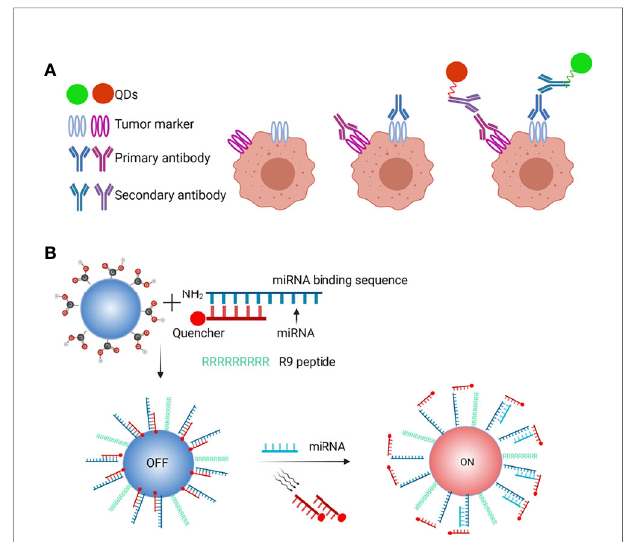
FIGURE 5 | QDs-based probes in microRNA and multiplexed biomarkers detection. (A) Schematic of QDs-based microRNA nanosensor, (B) QDs for facile and simultaneous detection of multiple